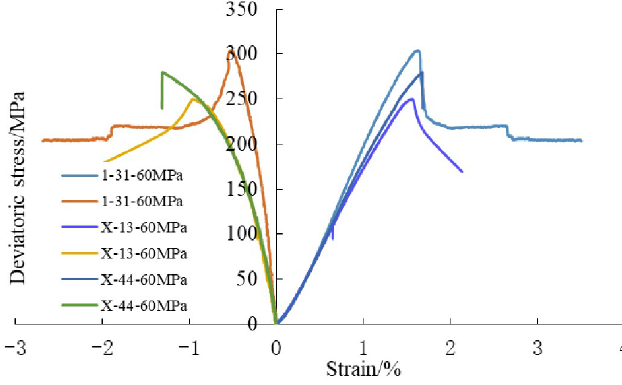
pressure under different stress paths was statistically analyzed, and the results were shown in Fig 6. The peak stress is sensitive to confining pressure. With the increasing of initial confining pressure, the peak stress increases linearly. Previous studies by scholars have shown that the strength of rock is not only related to the geological environment, but also to the stress path of loading and unloading [20–21].